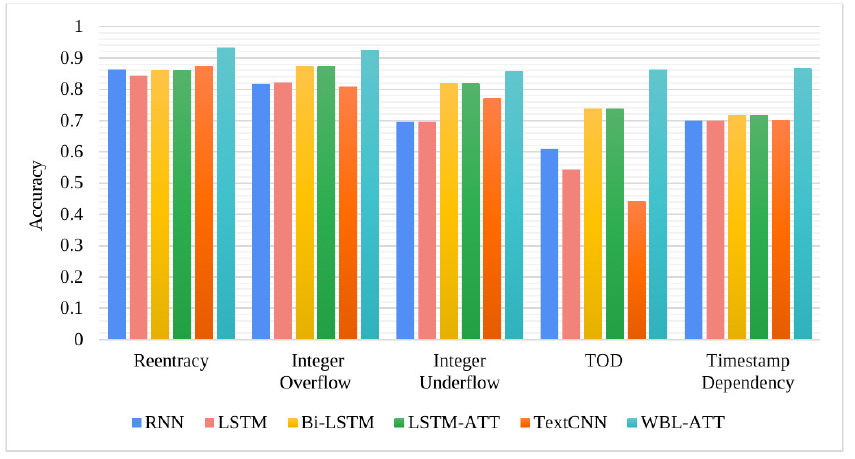
Figure 6. Accuracy of five vulnerabilities Figure 6 . Accuracy of five vulnerabilities detection.